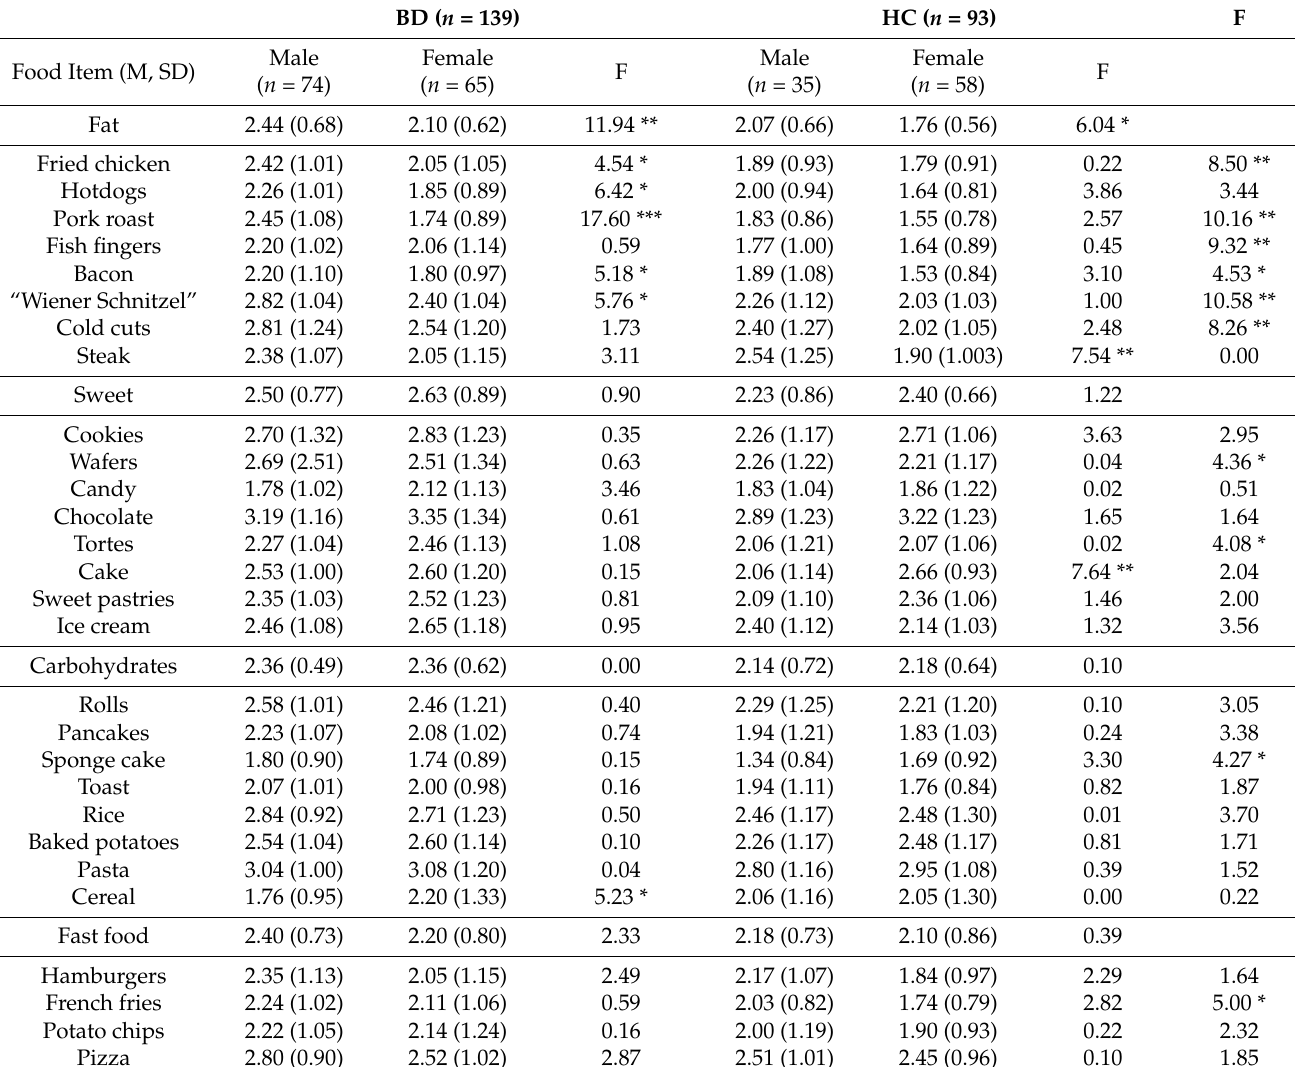
Table 2. Differences in craving for the 28 food items of the FCI between individuals with BD and HC stratified by sex (analyzed by